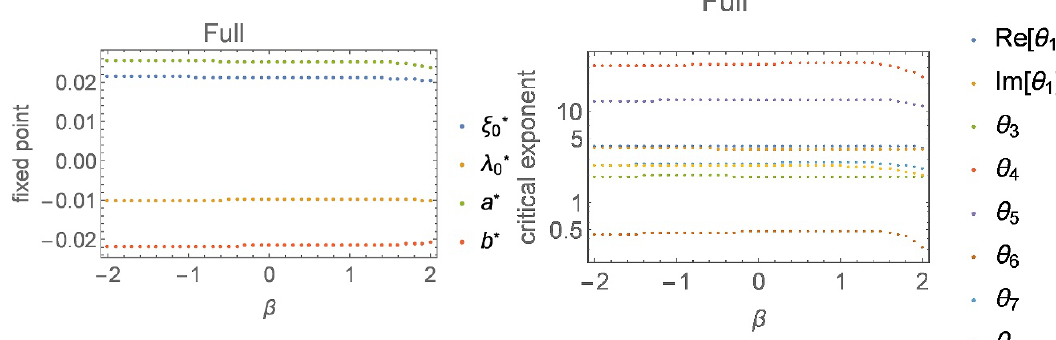
Figure 10 . The dependences of the stable (cid:12)xed point and the stable critical exponent on (cid:12) in the \full" theory